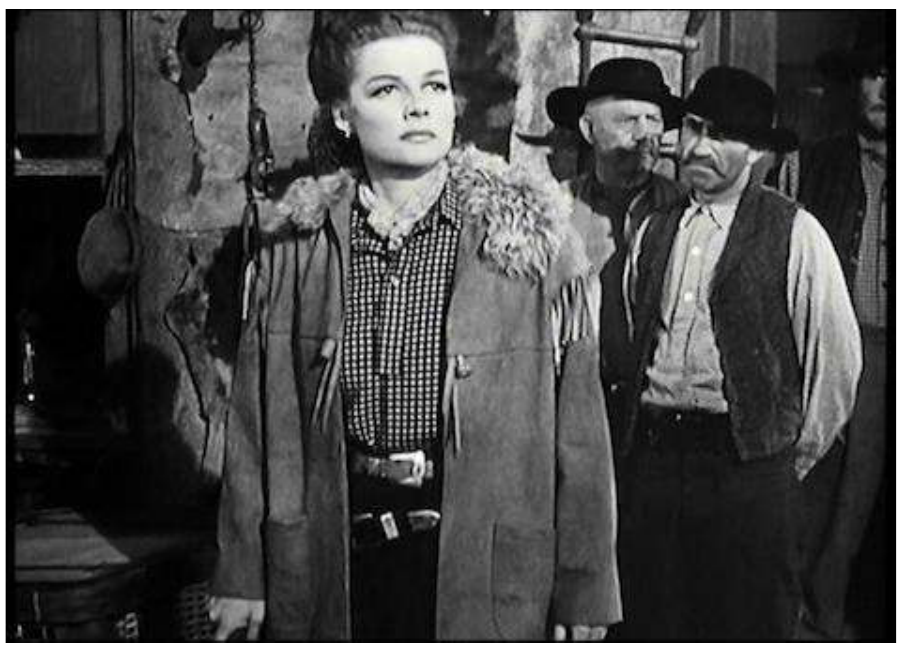
Figure 19: Georgia as Calamity Jane in Silver River